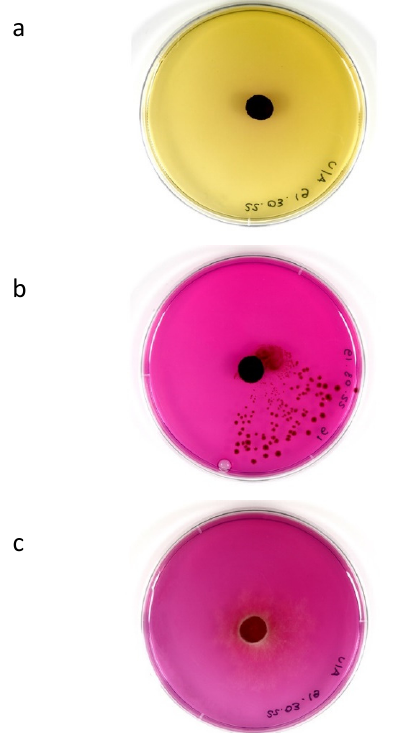
Figure 1. Urease Activity after 3 days of incubation (a) Control, (b) P. chrysogenum MUM 9743 and (b) N. crassa MUM 9208. Biominerals formed in the presence of P. chrysogenum MUM 9743 presented clusters of larger crystals than those formed in the presence of N. crassa MUM 9208. The Fig. 2a shows a typical crystal formed in the samples with P. chrysogenum MUM 9743 showed a mineral with 35.4 μ m diameter. The average diameter present on samples to P. chrysogenum clusters of crystals. Neurospora crassa MUM 9208 show crystals with a maximum diameter of 26.3 μ m with 18.3 μ